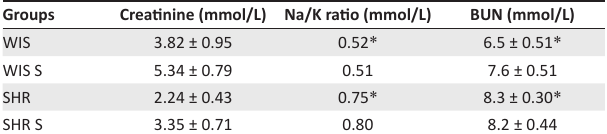
TABLE 5: Effect of multivitamin-multimineral supplementation on urinary creatinine, sodium to potassium ratio and blood urea nitrogen in spontaneously hypertensive and Wistar rats for week eight. Groups